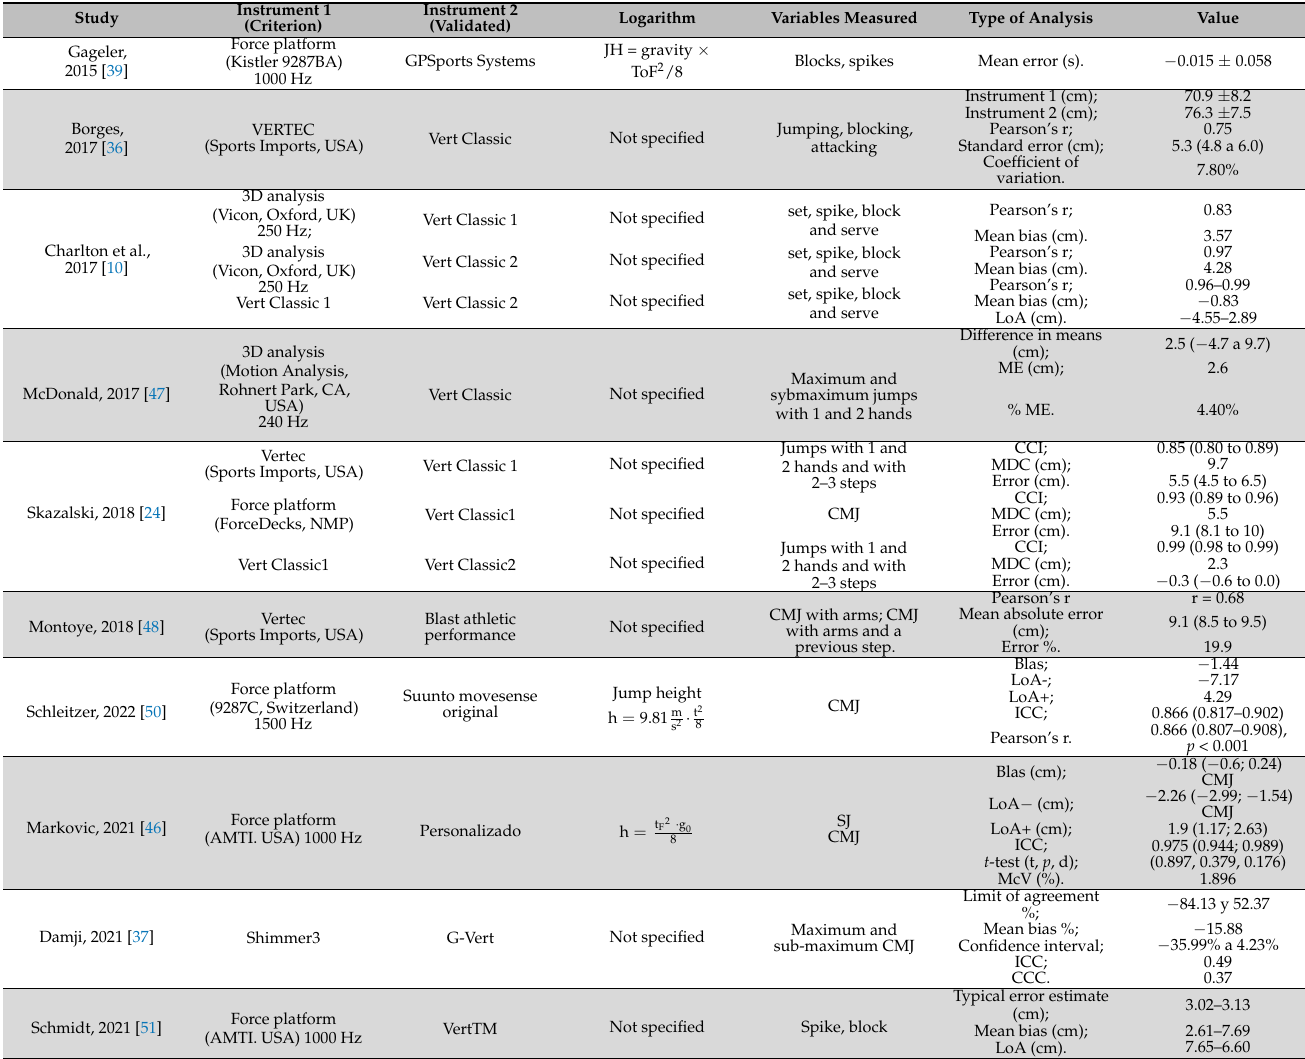
Table 6. Reliability characteristics of the studies